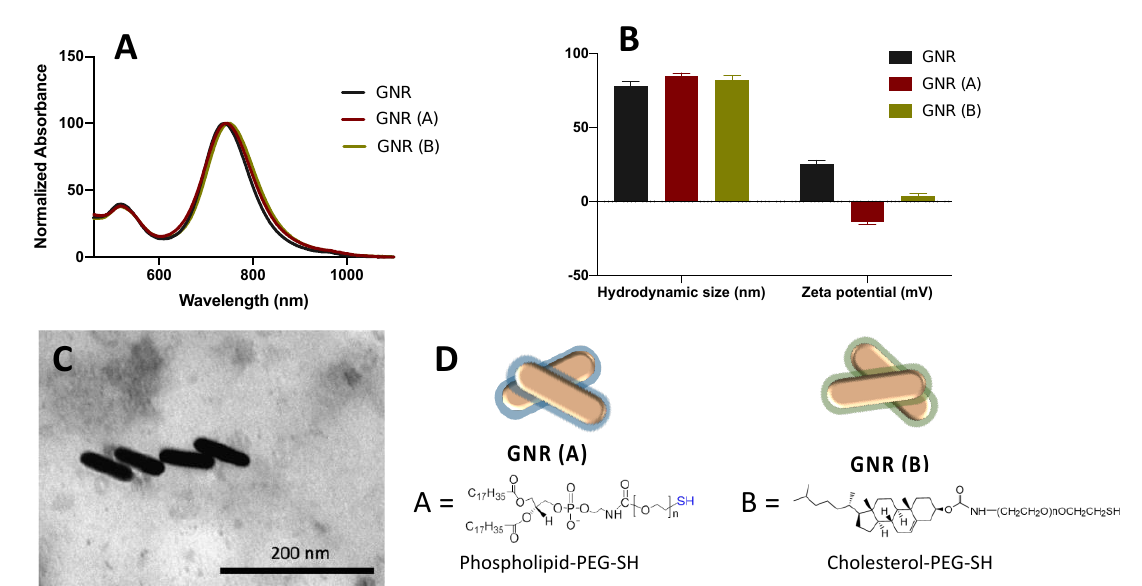
Figure 1. ( A ) UV-Vis absorption spectra of GNR before and after surface functionalization with PEG-phospholipid GNR (A) and PEG-Cholesterol GNR (B). ( B ) Hydrodynamic sizes and effective surface charges of GNR before and after surface functionalization with PEG-phospholipid; GNR (A) and PEG-Cholesterol; GNR (B). ( C ) TEM image of GNR (A) confirms the nanorods' size and shape. ( D ) Surface coating materials of GNR (A) and GNR (B).